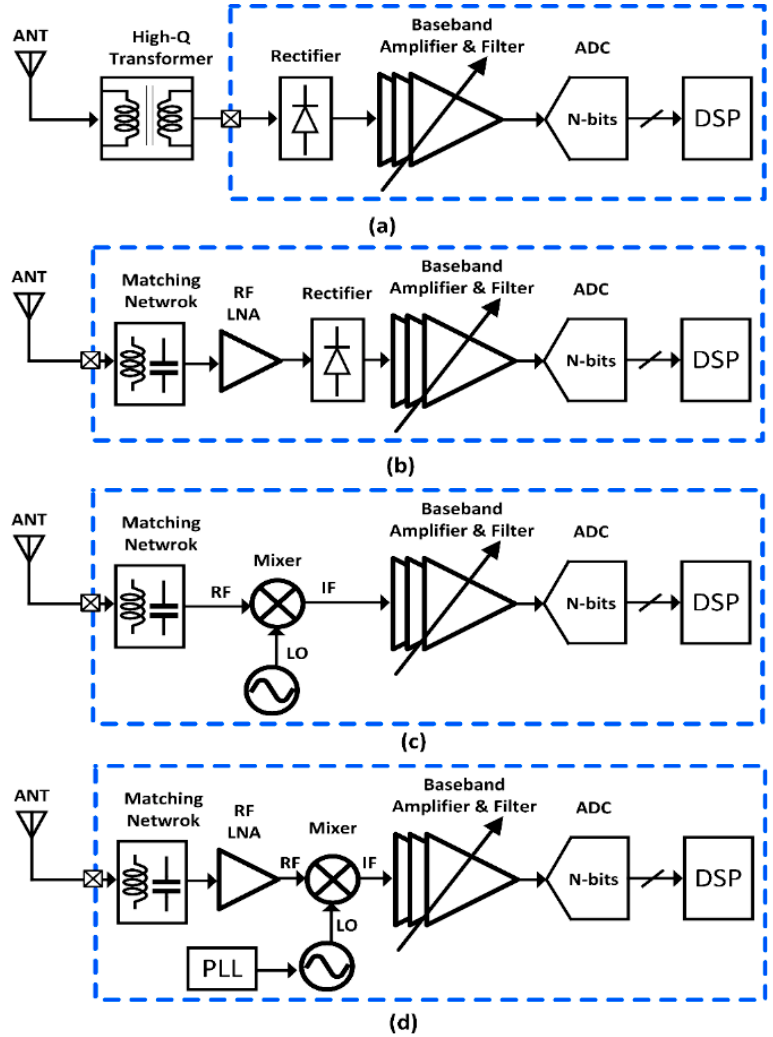
Figure 7. Common architectures of low power receivers: ( a ) energy-detector first; ( b ) energy-detector + LNA first; ( c ) mixer-first without PLL; ( d ) LNA-first architectures.